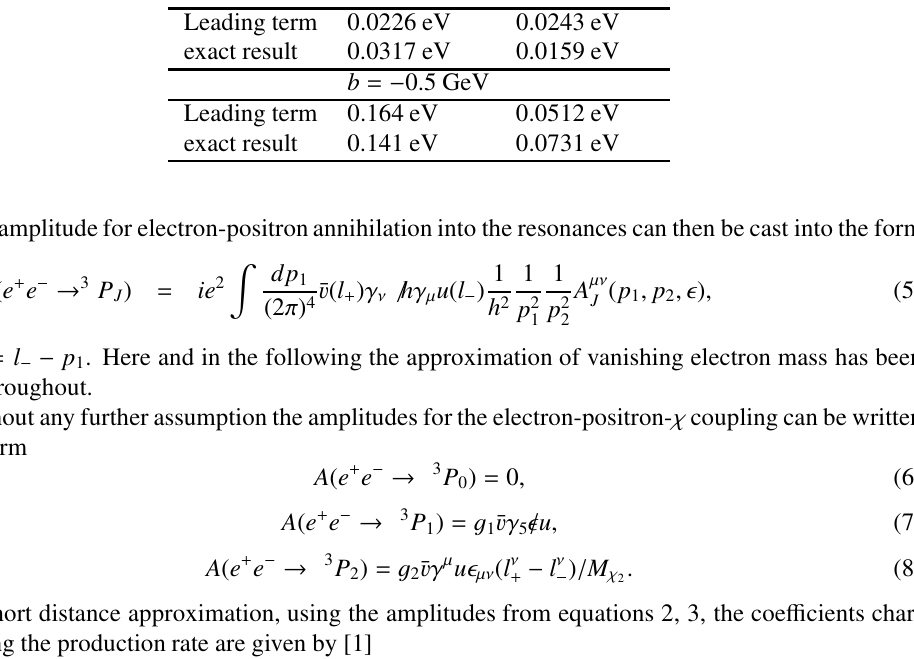
Table 1. Electronic widths for b =